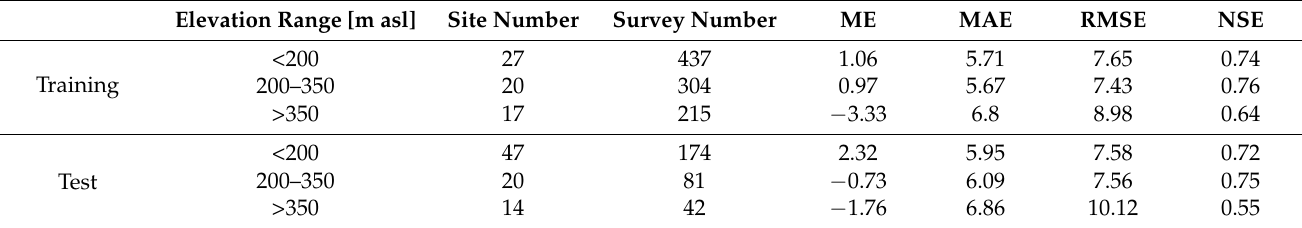
Table 7. Model performance metrics per elevation range. (ME mean error, MAE mean absolute error, RMSE root mean square error, NSE Nash-Sutcliffe